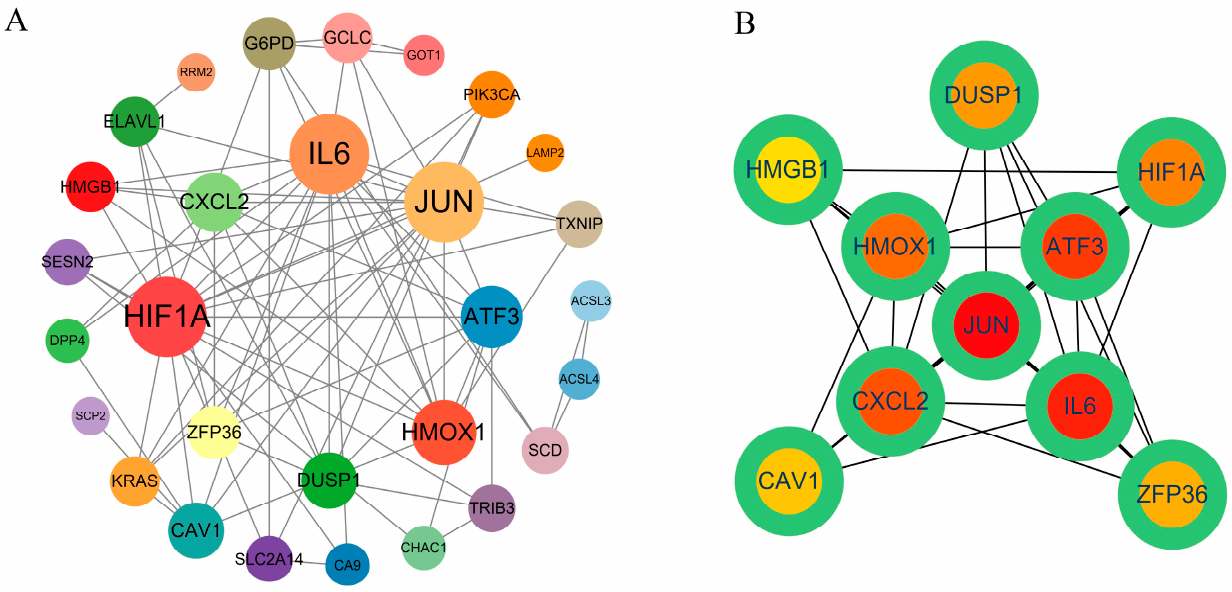
Figure 3. Construction of PPI network and hub gene screening. ( A ) PPI network constructed by string database and Cytoscape visualization. ( B ) Hub gene identified by Cytoscape based on MCC algorithm.